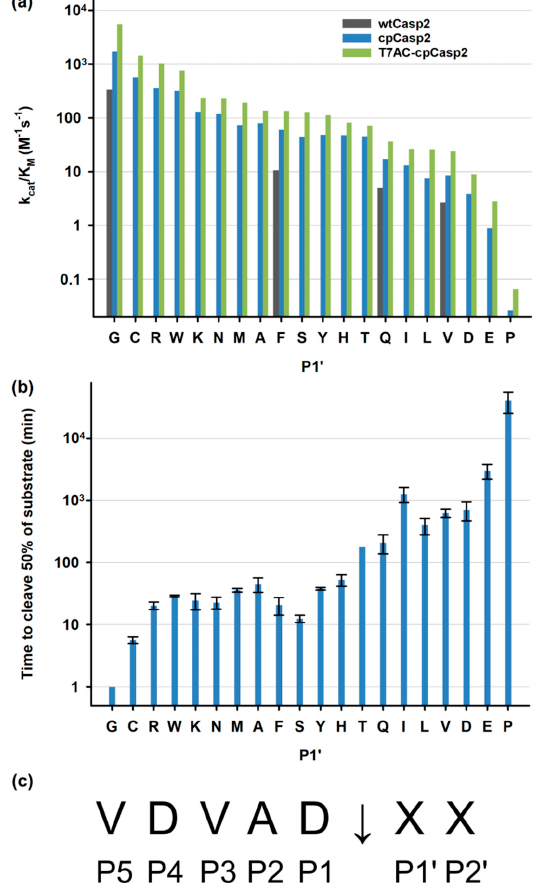
Figure 6. ( a ) FRET enzyme kinetics of wtCasp2, cpCasp2 and T7AC-cpCasp2. Due to the low available amount of wtCasp2 only G, F, Q and V were measured; ( b ) cleavage of the protein substrate E2 with all 20 amino acids in the P1 ′ position, using cpCasp2. Error bars are experimental standard deviation ( n = 3); ( c ) the recognitions sequence of Casp2 denoting the naming convention used in this work. ↓ marks the cleavage